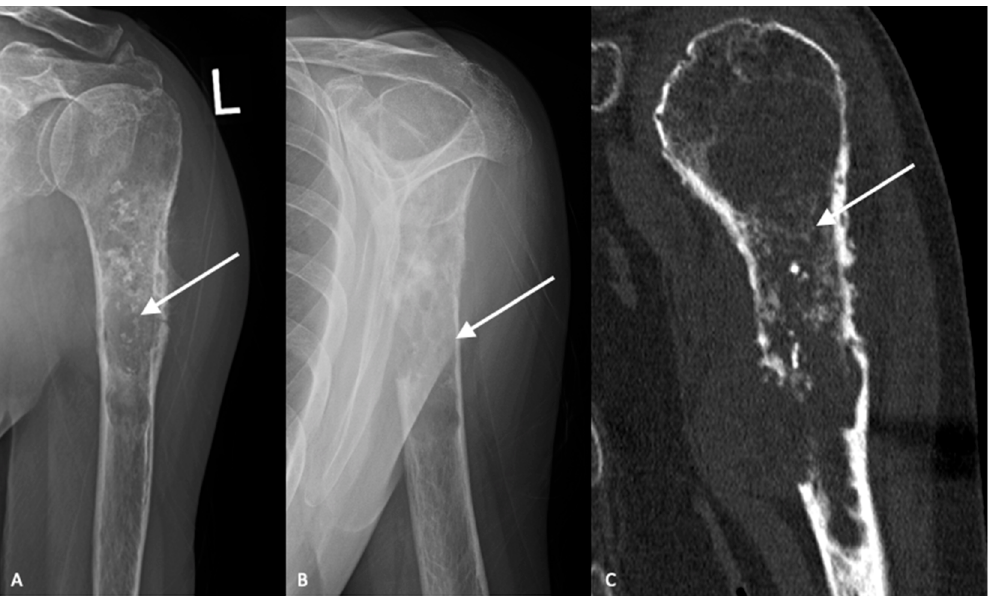
Figure 2. AP ( A ) and lateral ( B ) radiographs demonstrate an aggressive, heterogenous lytic lesion in the left proximal humerus with a wide zone of transition (white arrows). The lesion measures greater than 5 cm in length. Chondroid matrix is demonstrated. Periosteal reaction is present at the lateral aspect. There is a large area of cortical breakthrough at the anterior cortex, in addition to numerous areas of endosteal scalloping. Computed tomography ( C ) further demonstrates the cortical disruption and chondroid matrix formation (white arrow).